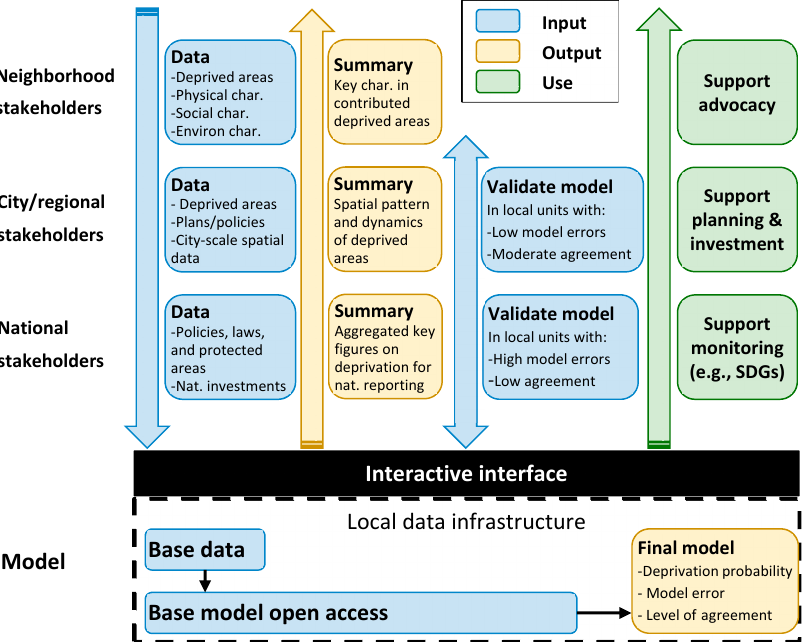
Figure 3. Outline of an integrated deprived area mapping “system” (adapted from [71]). SDGs: sustainable development goals.